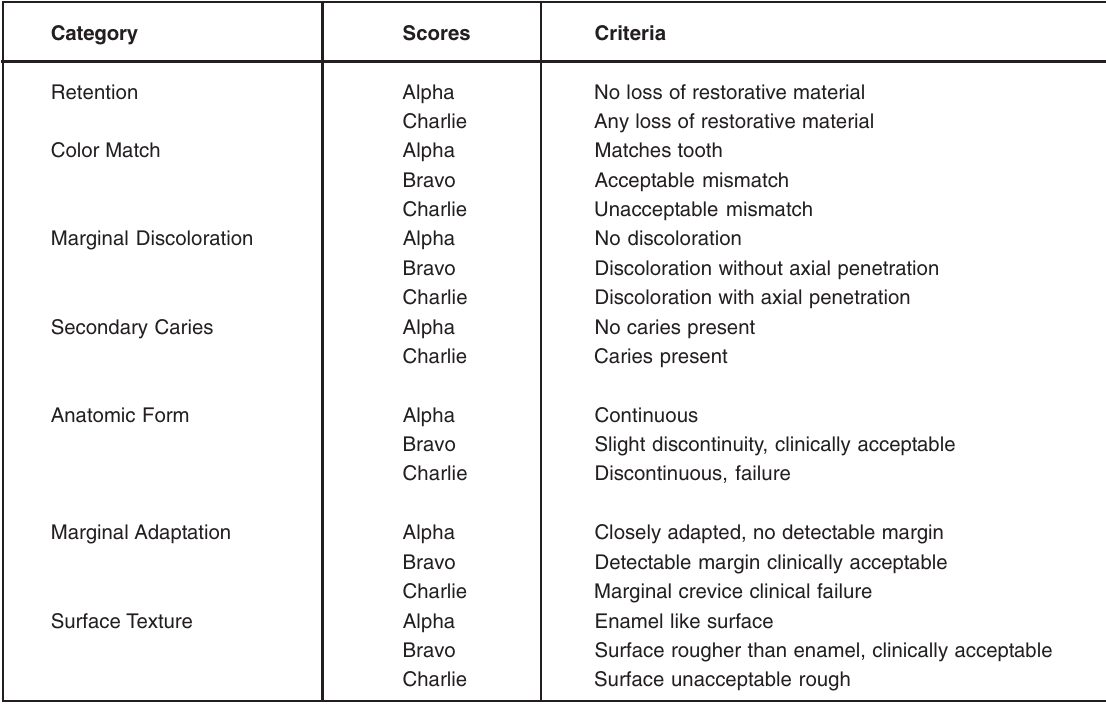
FIGURE 1- Criteria used to evaluate USPHS (1)